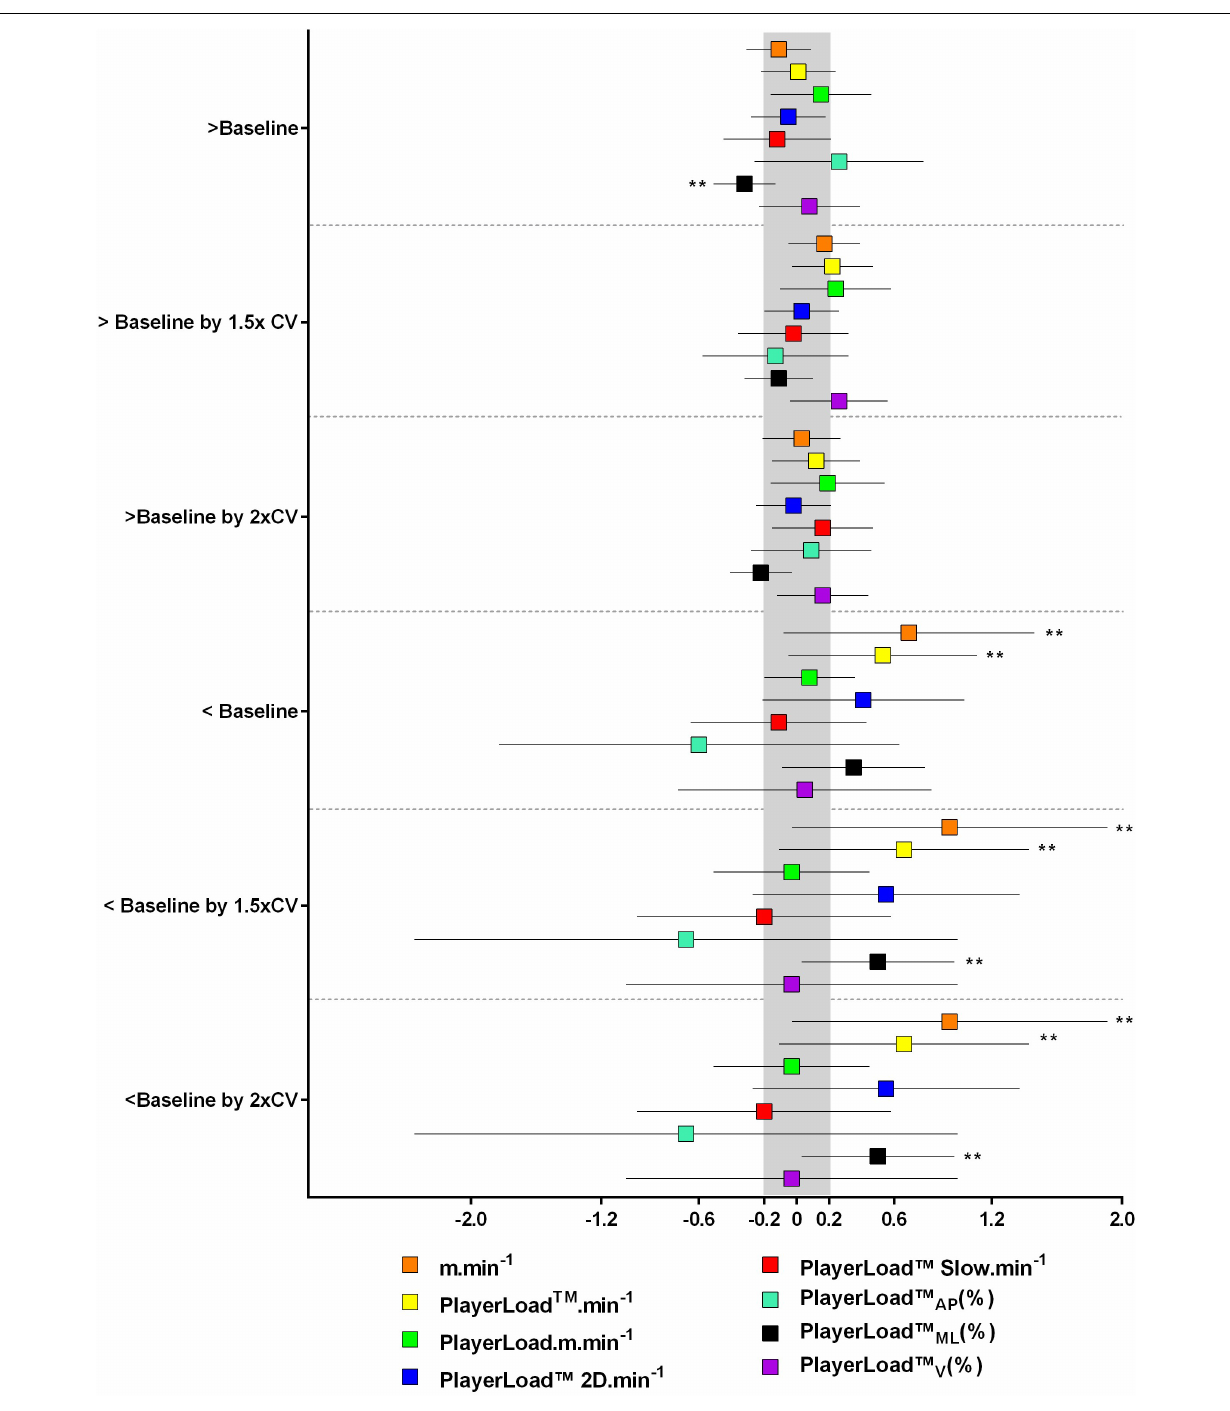
FIGURE 3 | Change in match exercise intensity based on small-sided game; SSG PlayerLoad TM per relative distance (meter per minute); PL · m · min − 1 < and > baseline, by more than 1.0, 1.5, and 2.0x %CV. Symbols denote a ∗∗ likely, ∗∗∗ very likely, and ∗∗∗∗ most likely chance that the change has exceeded the smallest worthwile change of 0.2 (shaded in